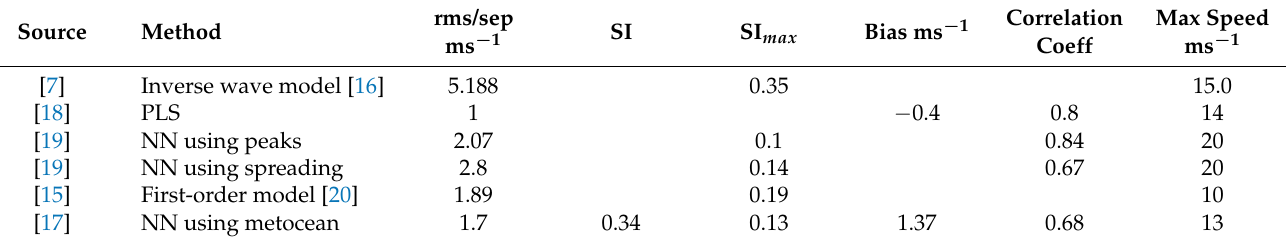
Table 1. Published wind speed